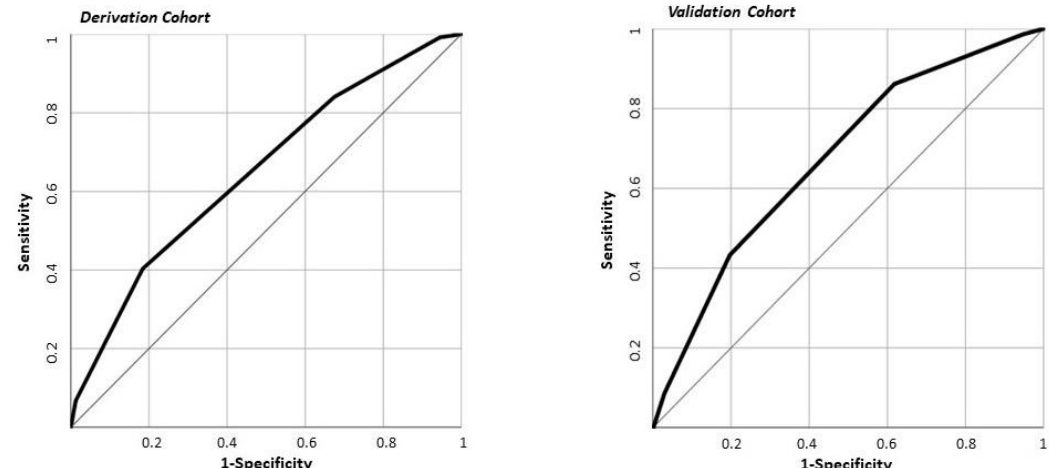
Figure 1. Receiver operating characteristic (ROC) curve of PACO-D score with respect to complicated diverticulitis in derivation (1089 patients) and in validation (282 patients) cohorts. The area under the ROC curve was 0.674 (0.638–0.709) in the derivation cohort and 0.648 (0.584–0.713) in the validation cohort ( p = 0.489).